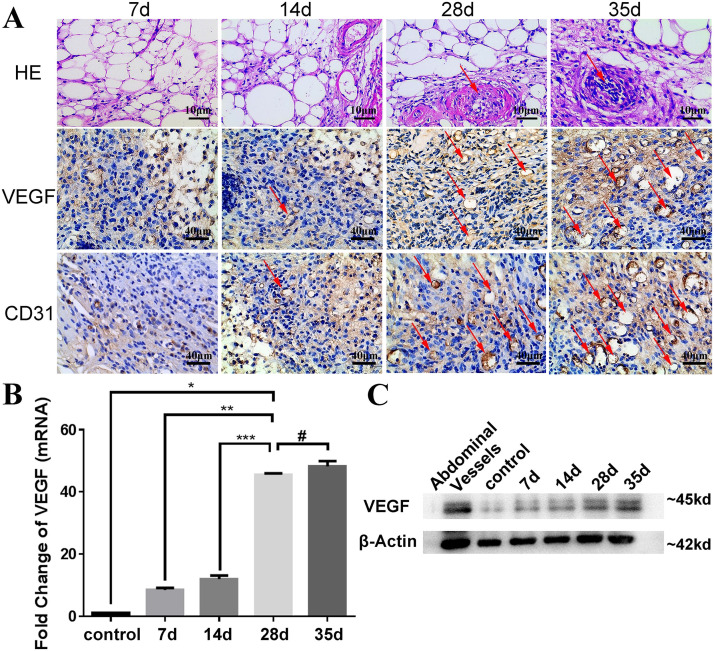
Highly developed microvascularized network established in the TEC on day 28 post-implantation.(A) HE images (1st row; scale bars: 10 μm) and histological analysis (2nd and 3rd rows; scale bars: 40 μm) of a prevascularized TEC on days 7, 14, 28 and 35. Red arrows indicate blood vessels in HE staining (1st row; scale bars: 10 μm). Microvessels were stained with anti-VEGF and anti-CD31, as marked separately by red arrows (2nd and 3rd rows; scale bars: 40 μm). (B) Levels of VEGF mRNA expression were quantified. The extent of prevascularization confirmed a significant increase at 28 d compared with 7 d and 14 d (p**<0.001, p***<0.001) and showed no significant difference between the 28 d and 35 d groups (p# = 0.0538). (C) Western blot analysis indicated VEGF protein expression levels at different time points in TECs. The control group had a chamber (but had no Matrigel™ and no heparin), and the sample came from the fat pad tissue near the superficial epigastric vessel. Data are shown as the mean ± SD and are representative of three separate experiments.